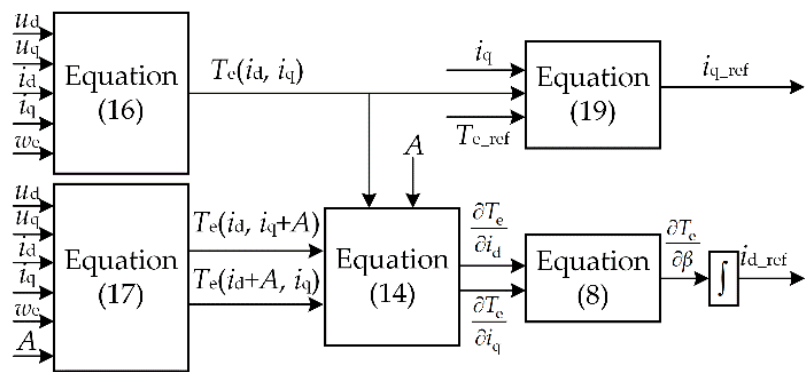
Figure 1. Schematic diagram of VCSIM.